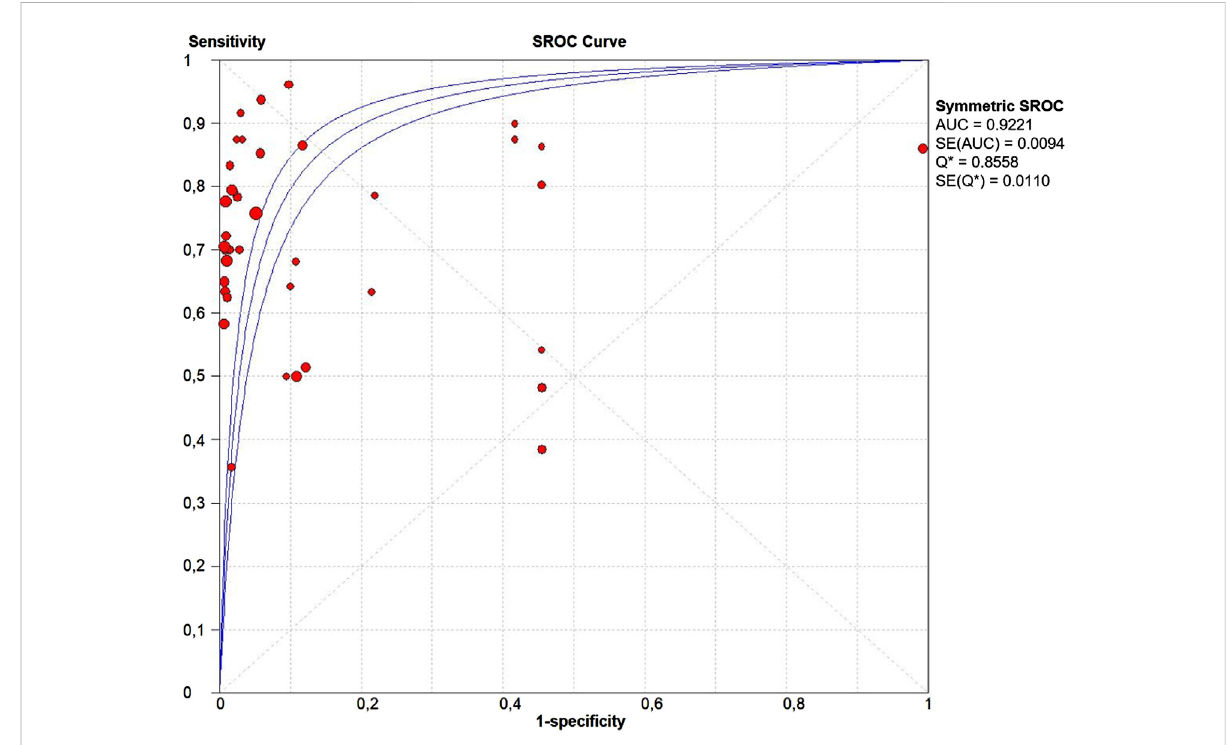
FIGURE 4 Thesummaryreceiver operatingcharacteristic(SROC)curve. Pointsrepresentthepair ofsensitivityand speci fi cityatagiven threshold for each study. The area under the curve was 0.92 (SE =